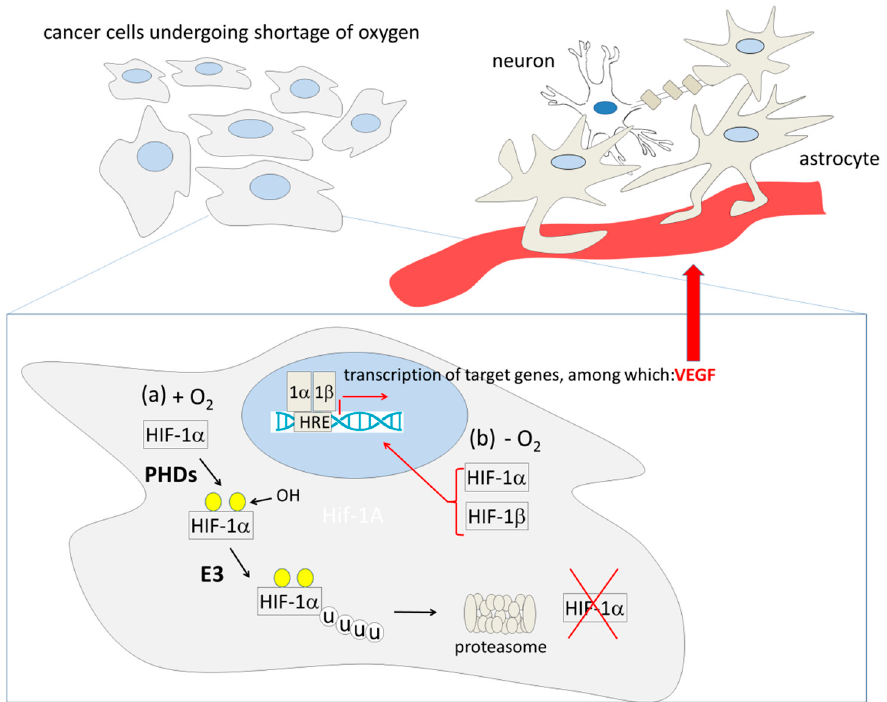
Figure 3. Dependence of angiogenic processes on oxygen shortage and activation of the hypoxia- induced factor 1 (HIF-1). HIF-1 factor is composed by two subunits, HIF-1 α and HIF-1 β . In normoxic conditions (a, +O 2 ), HIF-1 α is hydroxylated by prolyl hydroxylase domain proteins (PHDs), poly-ubiquitinated (u) by an E3 ligase, and degraded by the proteasome. When cells (including cancer cells) undergo oxygen shortage (b, -O 2 ), PHDs, which use molecular oxygen as a substrate in the hydroxylation reaction, cannot modify any more HIF-1 α ; as a consequence, HIF-1 α is no longer degraded, and combines with HIF-1 β ; the HIF-1 α / HIF-1 β dimer enters the nucleus, where it binds to the HIF-1-response elements (HREs) and activates its target genes, including the one encoding vascular endothelial growth factor (VEGF), which in turn stimulates the endothelial cells of the vessels to migrate, proliferate, and differentiate, forming new vessels [273].